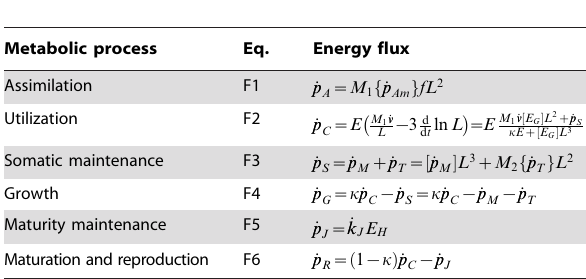
Table 2. Dynamic energy budget of Pacific bluefin tuna I: energy fluxes. Table 3. Dynamic energy budget of Pacific bluefin tuna II: dynamics of state variables and the reproduction